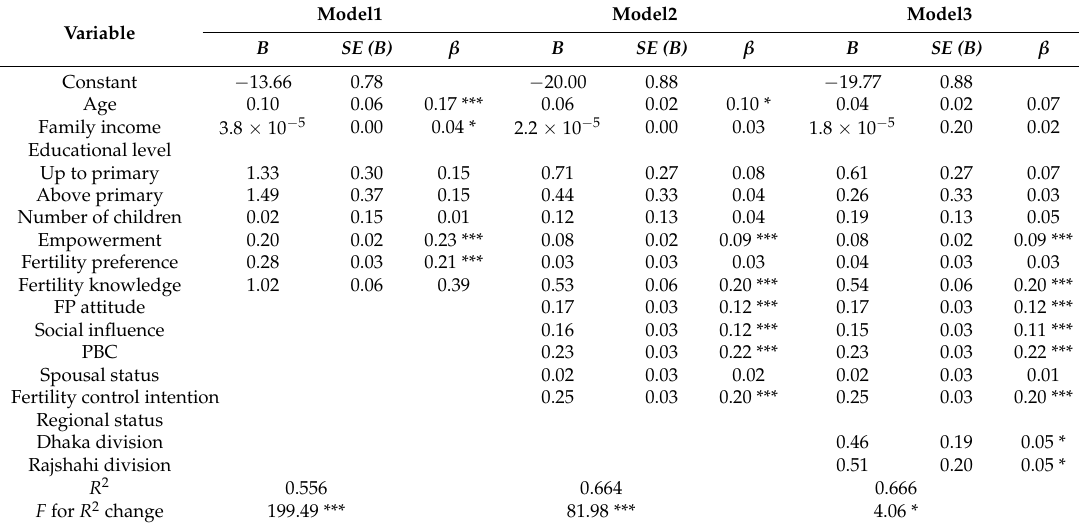
Table 4. Summary of hierarchical regression analysis for variables predicting rural women’s fertility control behavior ( n =